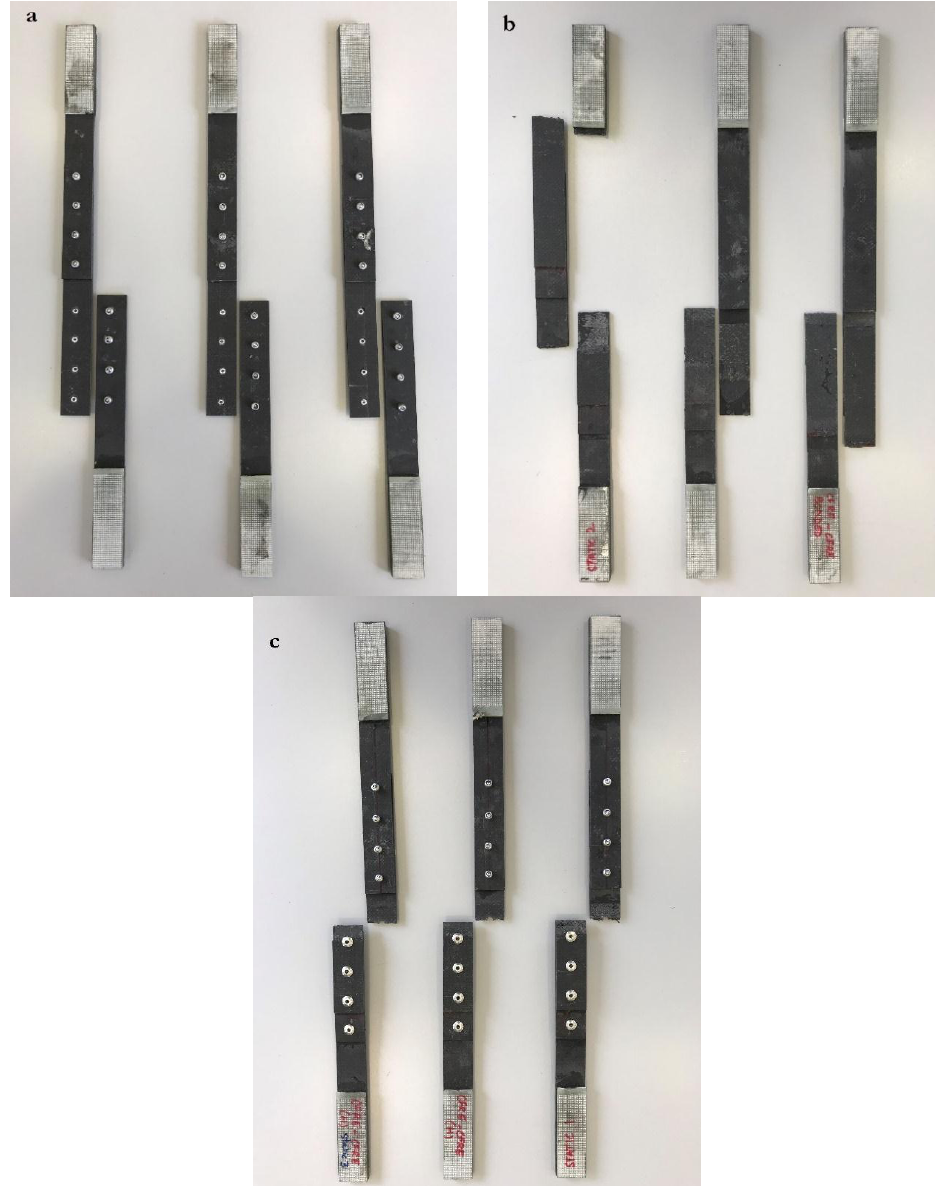
Figure 5. Failure of composite-composite ( a ) riveted, ( b ) adhesive bonded, and ( c ) hybrid joints. Table 6. Experimental results for strength of riveted, adhesive bonded, and hybrid joints with composite substrate and metal doublers.